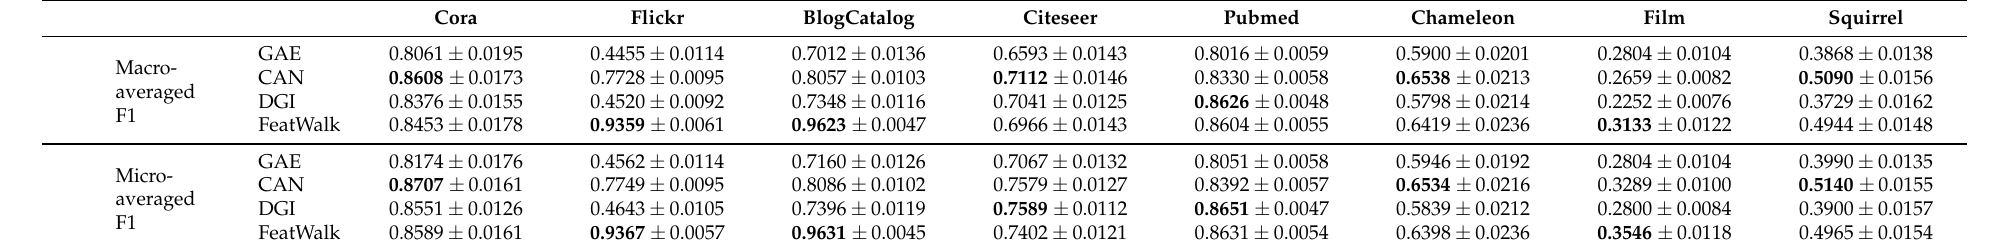
Table 6. Results in Task 1, i.e., classification fine tuned via validation set, on attributed networks, using random search to tune hyperparameters. Best results are shown in bold.